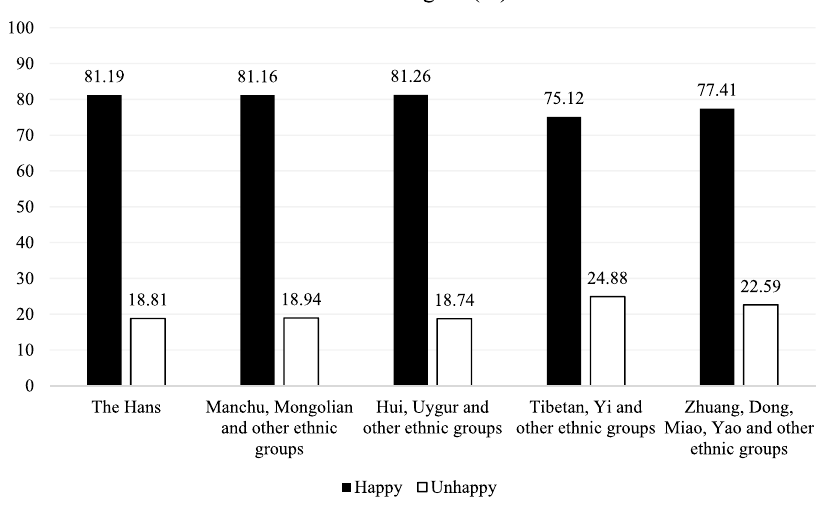
Fig. 1 Bar Graph showing the current state of the subjective well-being of ethnic minority residents in the western regions of